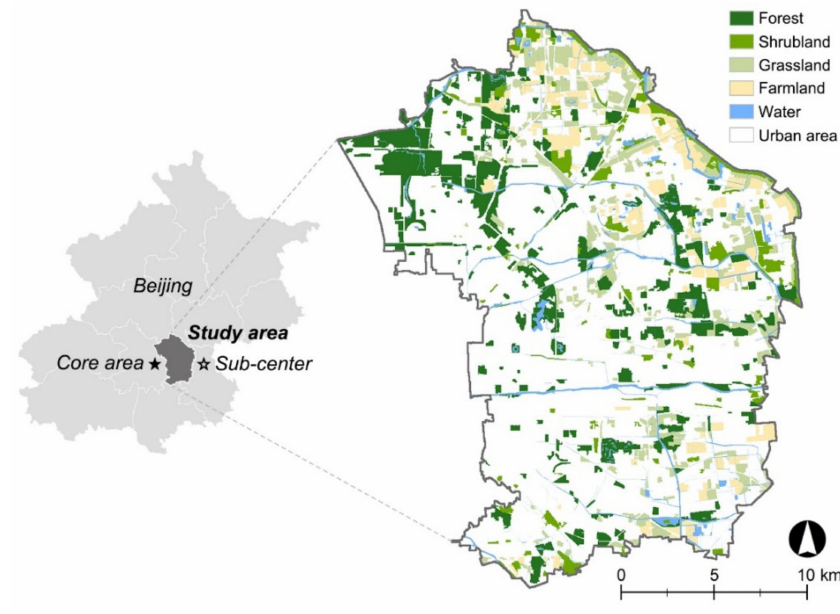
Figure 1. Location of the study area and land use in